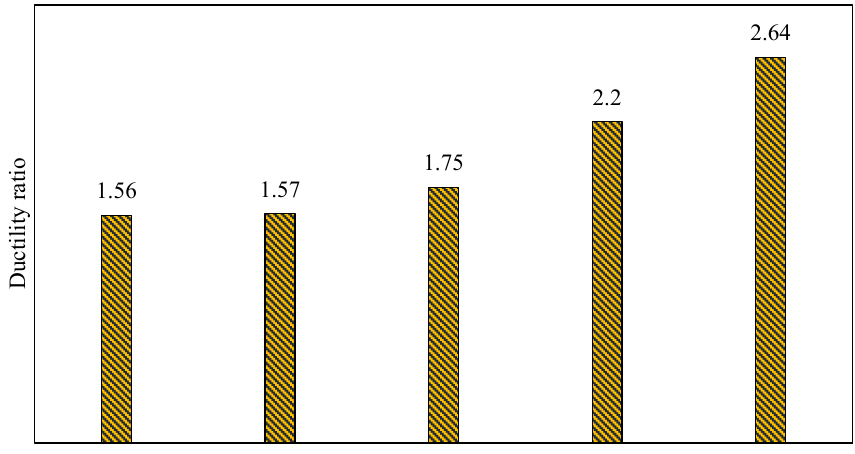
Figure 16. Ductility ratio of group 2.